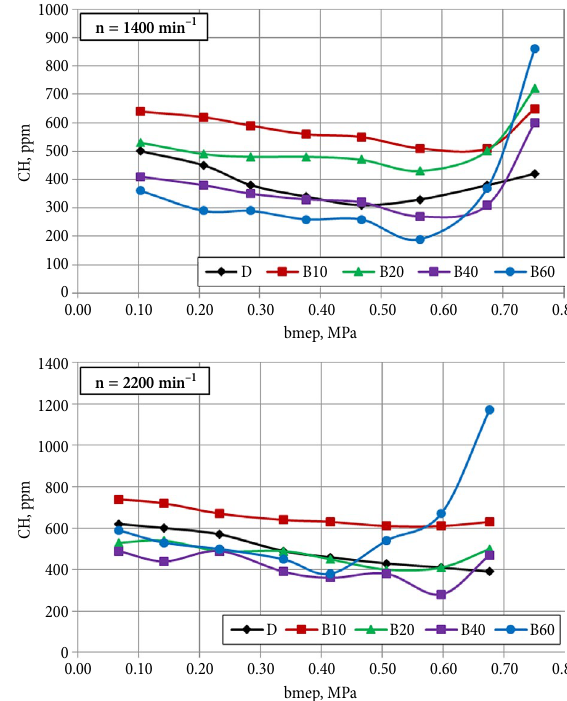
Fig. 9. The CO emissions as function of engine load ( bmep ) Fig. 10. The unburned hydrocarbons HC emissions